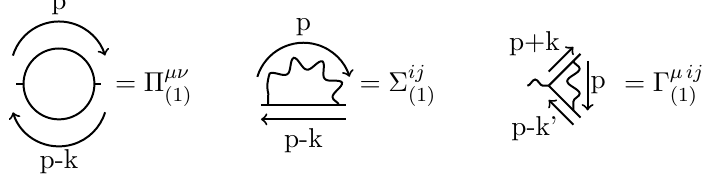
Figure 2 . Feynman rules for the action (1.1).